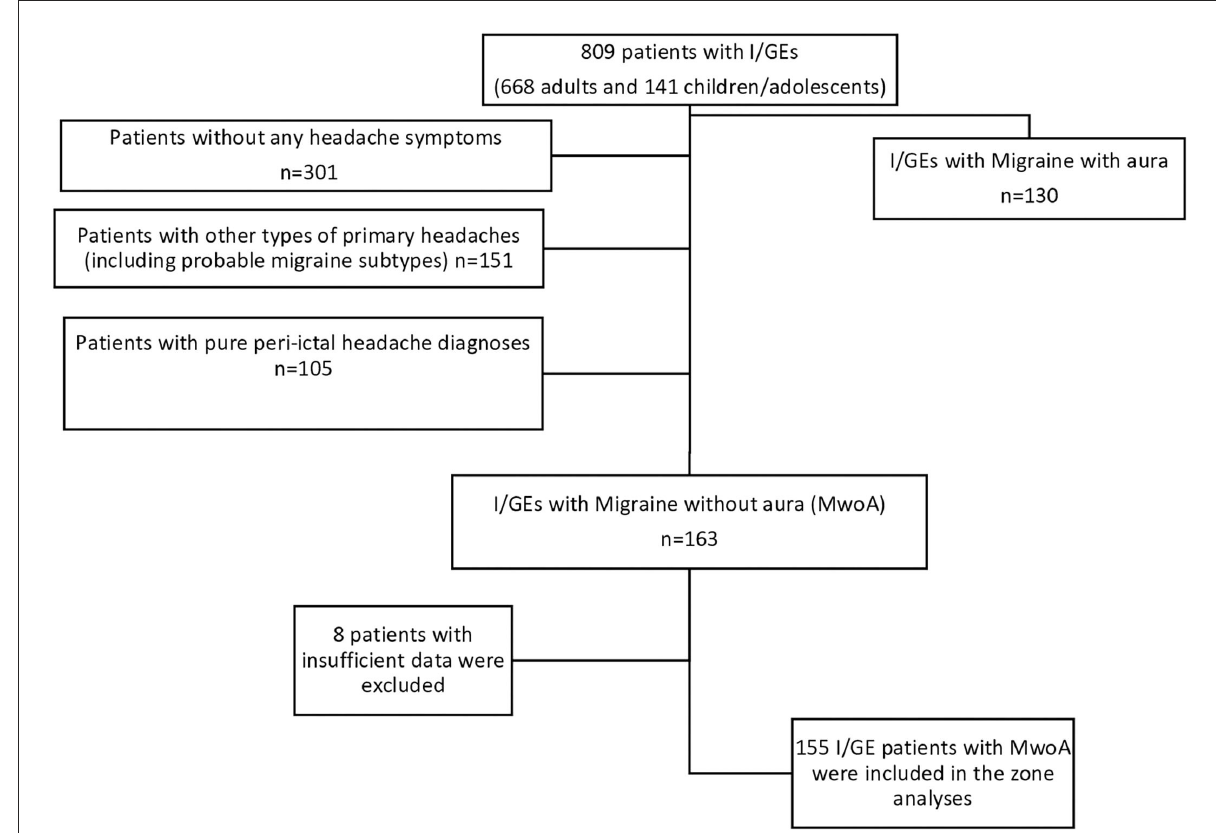
FIGURE1 Flowchart of the study. I/GE, idiopathic/genetic epilepsy; MwA, migraine with aura; MwoA, migraine without aura; n ,